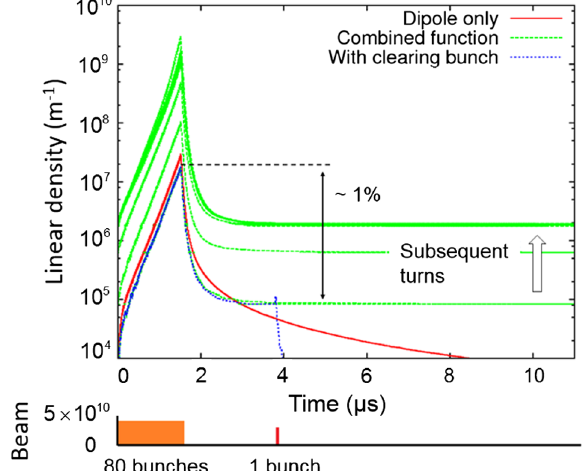
FIG. 4. In a combined function magnet the electron cloud accumulates over many revolutions, reaching much higher line density, than in a pure dipole. A clearing bunch destroys the trapped cloud, preventing the accumulation. Results of a numeri- cal simulation using the PEI